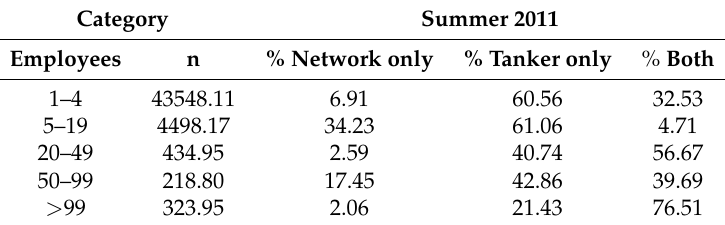
Table 4. Water user groups per category: Summer